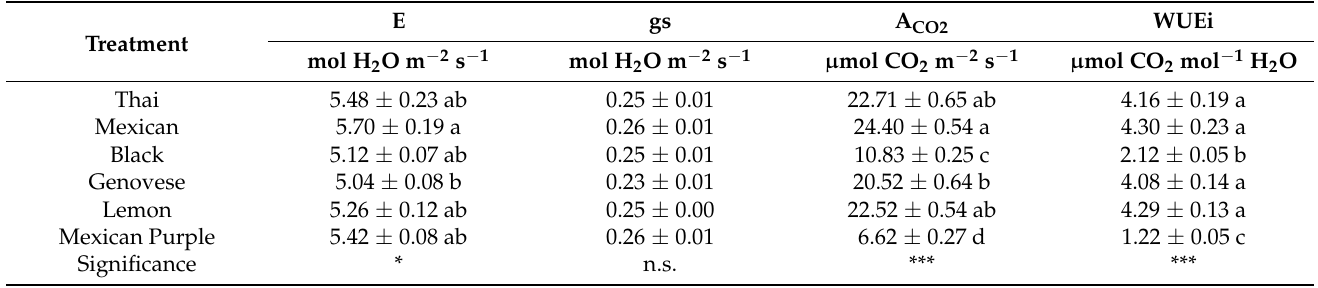
Data are mean values ± standard error, n = 4. Mean comparisons were performed by Tukey HSD test. Differ- ent letters indicate significant mean differences. n.s., *, and *** denote nonsignificant or significant effects at p ≤ 0.05 and 0.001,